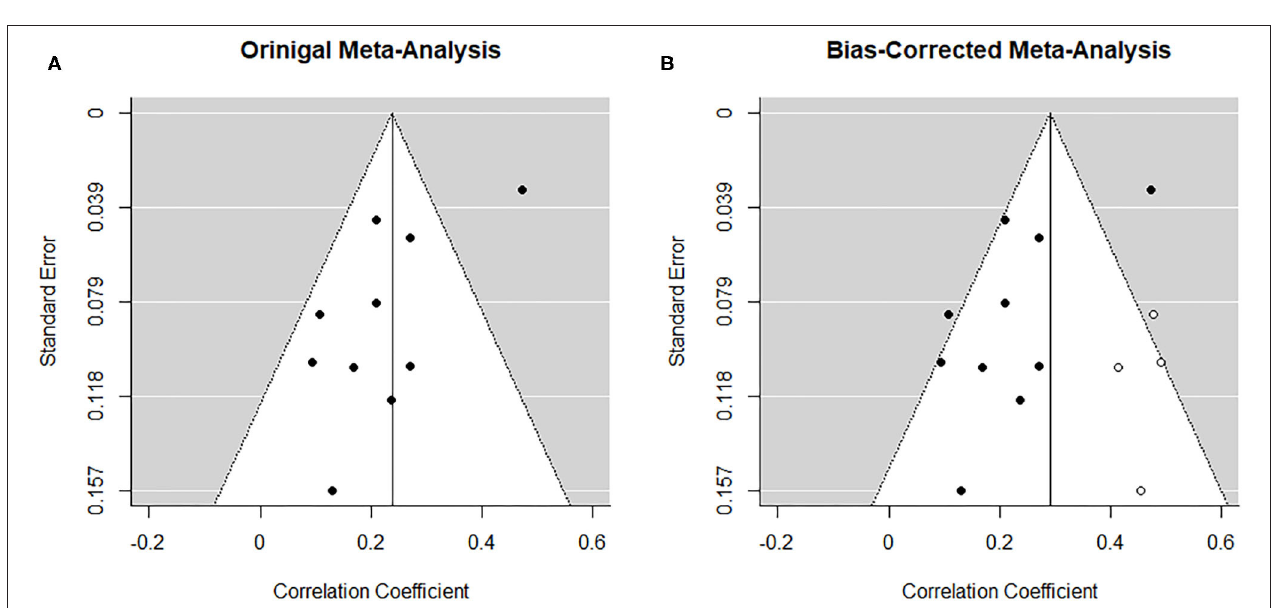
FIGURE 3 | Funnel plots before (A) and after (B) applying trim-and-fill method corresponding to the meta-analysis on the association between paternal and maternal depression during the prenatal period. The open dots indicate imputed studies.